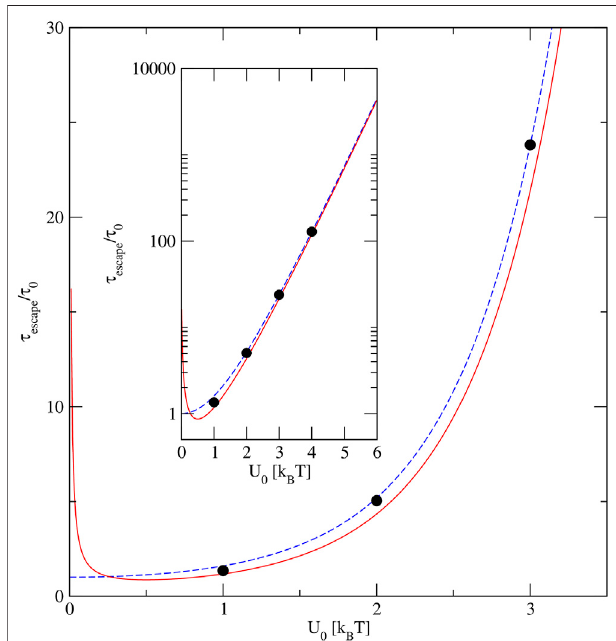
FIGURE13| (Coloronline):Escapetime τ escape (cid:2) 2 τ MFPT asafunctionof the barrier height U 0 . The black solid circles, the blue dashed-line and the red solid line have been obtained from Brownian dynamics, the Lifson-Jackson prescription( Eq.17 ),and theDalle-Ferrierformula( Eq.16 ),respectively. In all cases, τ 0 (cid:2) L 2 , L (cid:2) 1 . 0 × 10 − 6 m and D BD 0 (cid:2) D 0 (cid:2) 1 . 8 × 10 − 13 m 2 / s 2 D 0